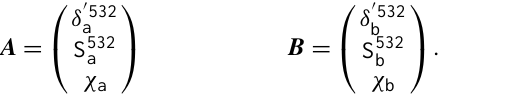
Fig. 1. Here two covariance matrices are arbitrarily selected to represent pure types. Points randomly selected from these distributions are shown in blue and purple. Blue and purple ellipses show the two-sigma contours of the covariance ma- trices for the pure types (when representing covariance ma- trices as ellipses, the major and minor axes are given by the square root of the eigenvalues while the directions are de- termined by the eigenvectors (Rodgers, 2000)). A specific mixture of the two pure types is calculated numerically by mixing the blue and purple points using three different lin- ear coefficients of mixing for the three dimensions, and these points are shown in orange. The coefficients are (0.6,